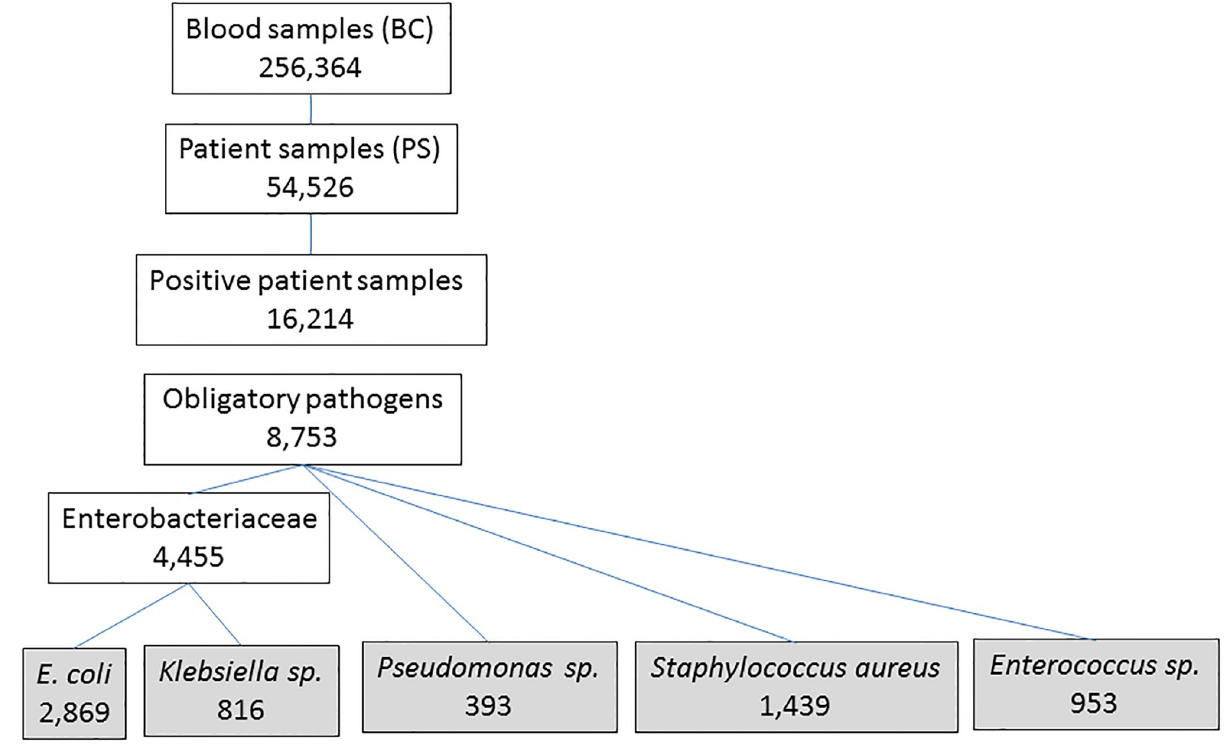
Fig 1. Number of samples and